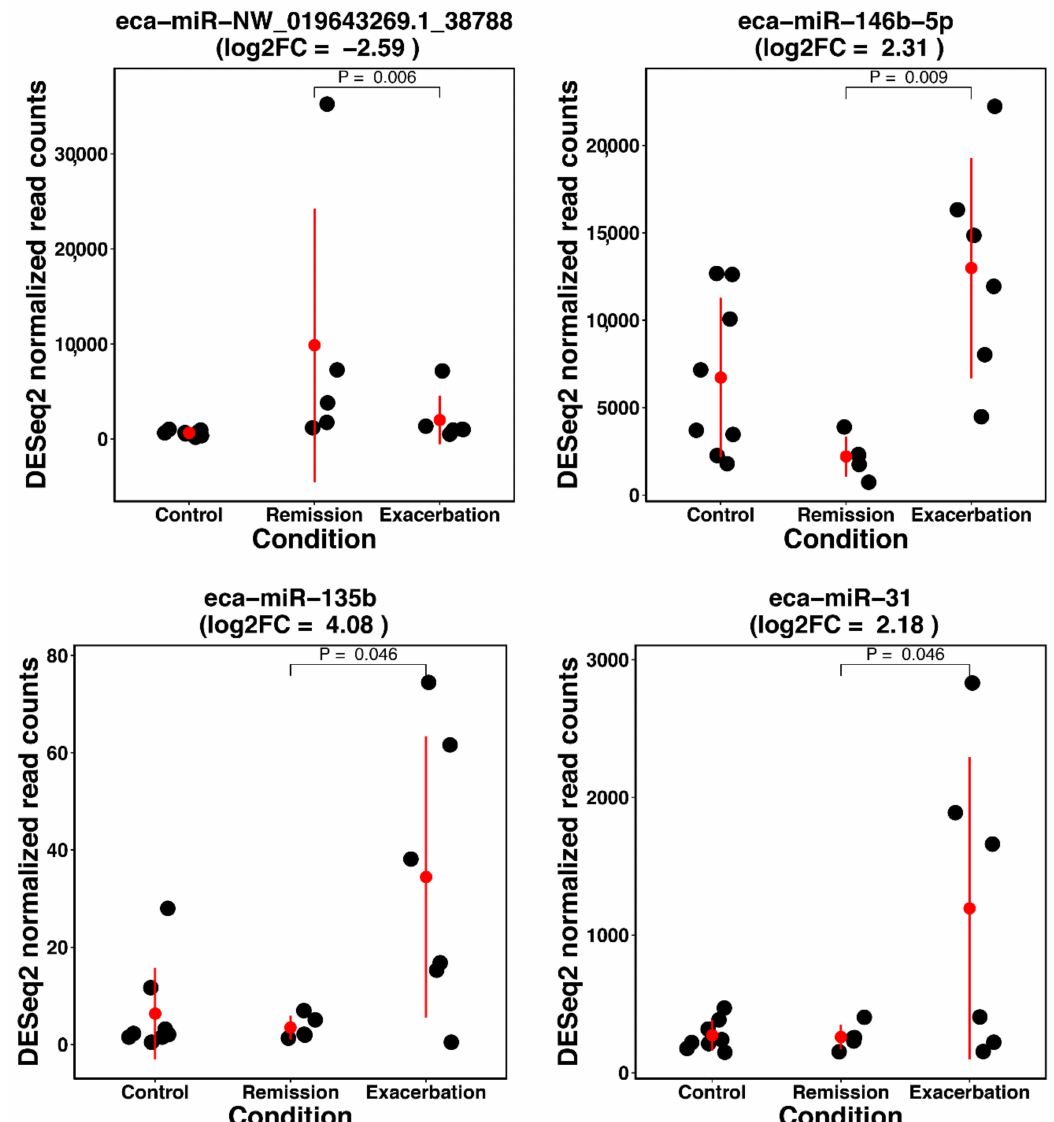
Figure A7. Obtained normalized read counts for all di ff erentially expressed miRNAs for the contrast exacerbation vs. remission. The red dot indicates the mean expression value and the red bars span the range of plus and minus one standard deviation. Adjusted p -values are listed for the contrast of